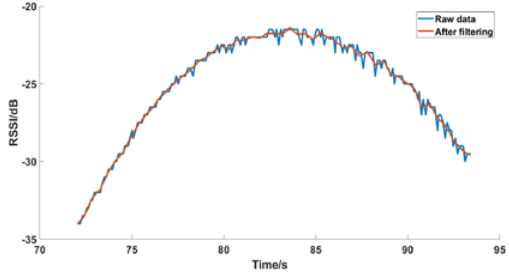
Figure 11. Least squares fitting.